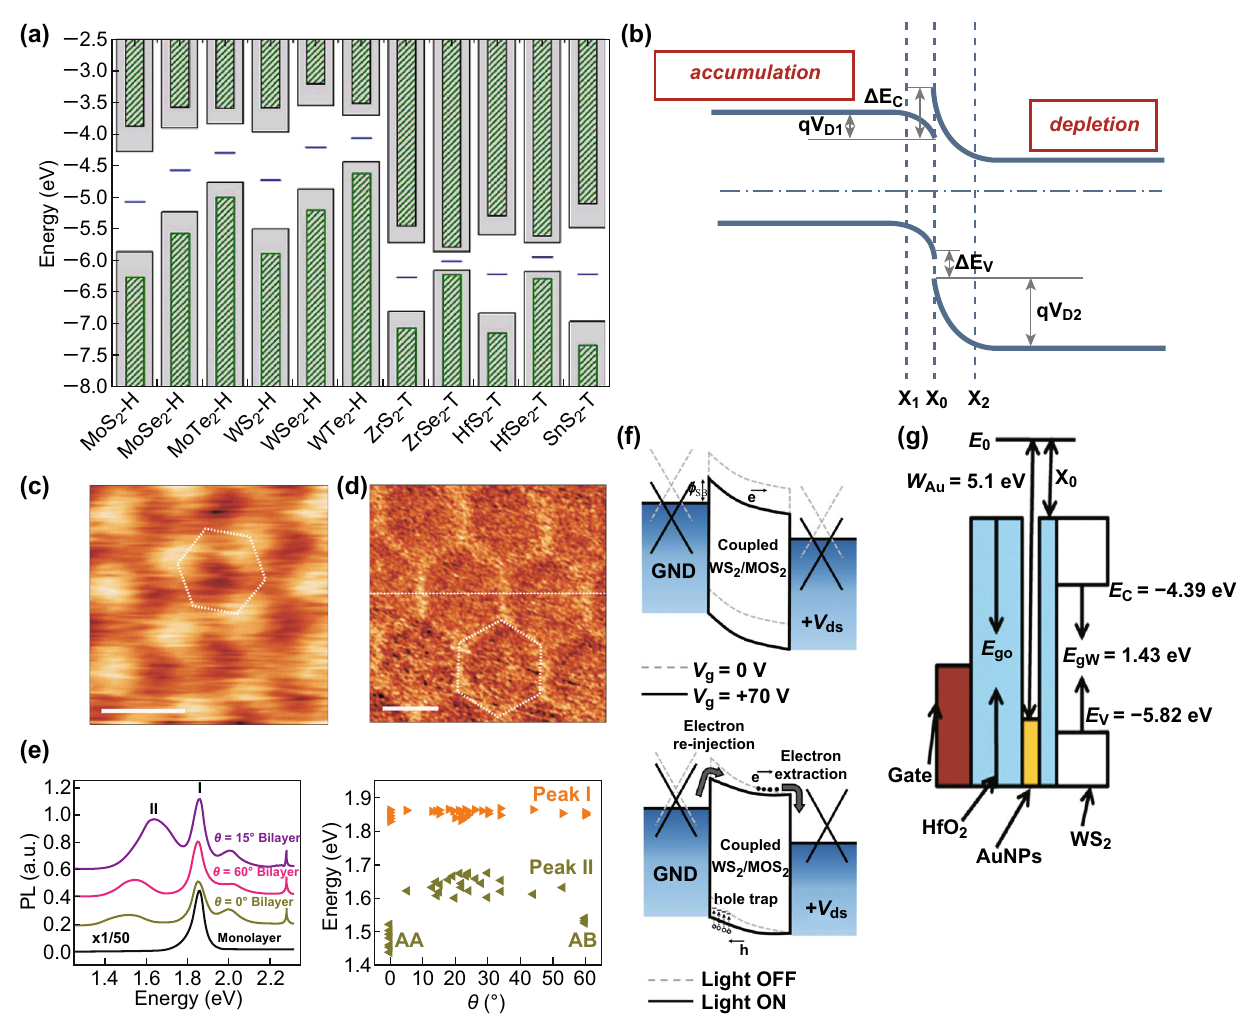
Fig. 3 Band alignment and band engineering methods. a Theoretical positions of VBM and CBM of VIB‑ and IVB‑TMDs calculated by PBE‑ SOC. Reprinted with permission from Ref. [33]. b Schematic diagram of band bending at the interface, forming a notch on the accumulation side and a peak on the depletion side. c , d STM measurements of hBN/graphene heterostructure stacked with the different rotation angle of 5° ( c ) and 0° ( d ). Reprinted with permission from Ref. [41]. e PL spectra of MoS 2 monolayer and bilayers with different twist angles, where peak I is related to the direct transition at K − valley and peak II may be associated with the indirect band gap. Reprinted with permission from